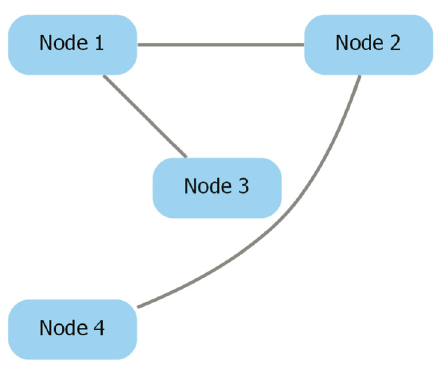
Figure 6. The network exported with the “Curved segments routed around nodes” option, as “splines = ‘true’” in the output Graphviz file.